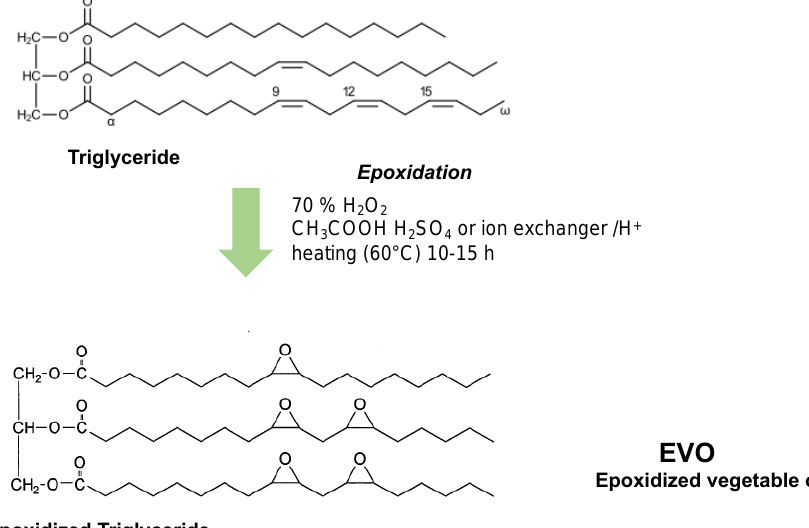
Figure 2. Chemical structure representation of triglycerides and epoxidation by Prileschajew’s reaction